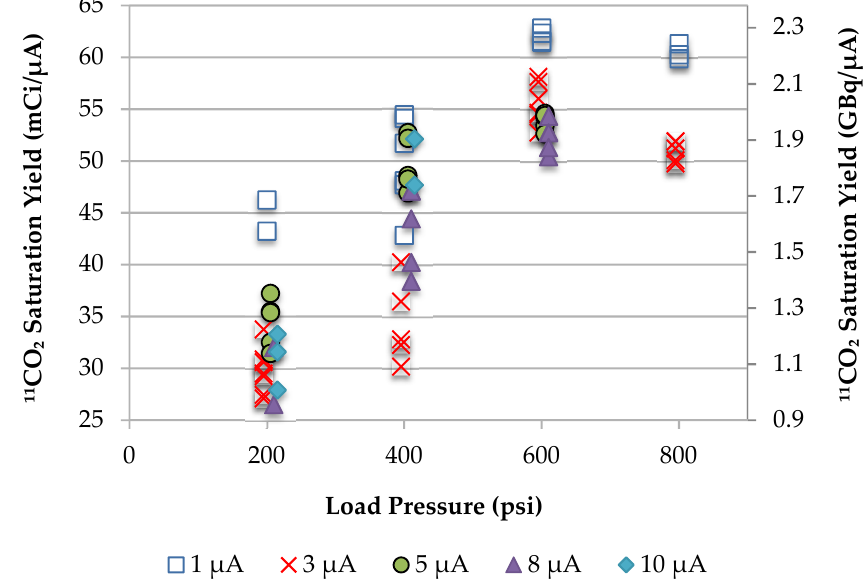
Figure 10. 11 CO 2 saturation yield for the BN-124 target using a fill gas of nitrogen with 1% oxygen.